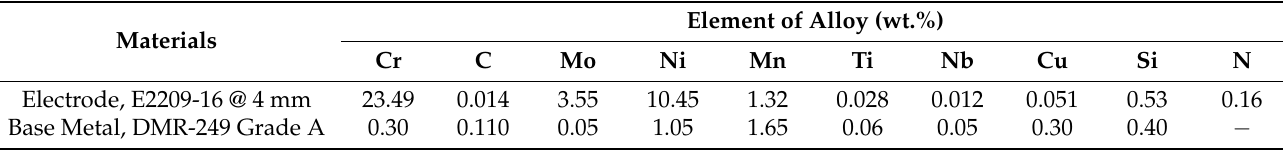
Table 1. Chemical elements for base metal and consumable welding.